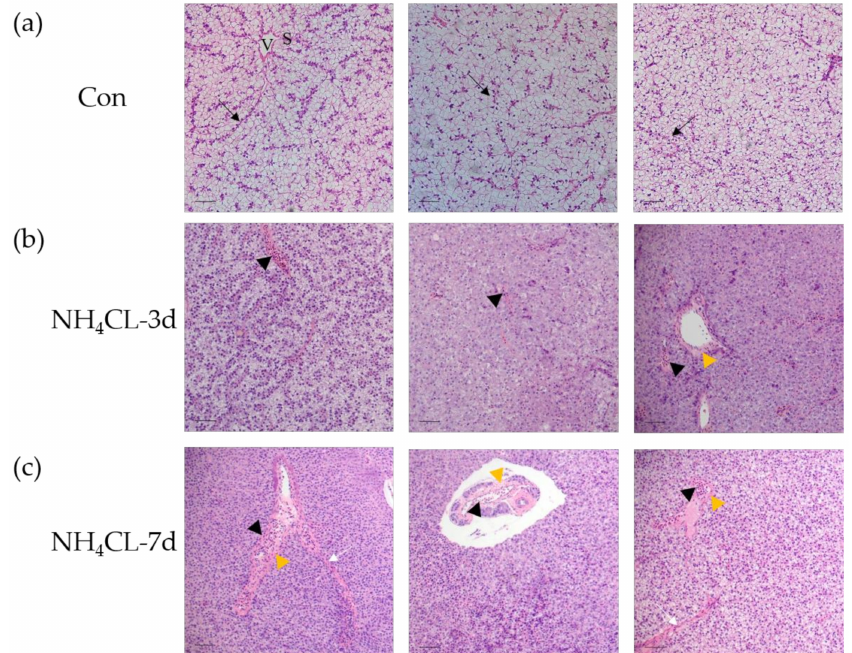
Figure 1. Ammonia exposure affected largemouth bass liver health. Hematoxylin-eosin (H. & e.) staining of paraffin sections of perch liver after ammonia exposure. V: venous tube; S: hepatic sinuses; black arrow: hepatic cord structure; black triangles: infiltration of inflammatory cells; yellow triangle: thickened vascular epithelium; white arrow: hepatic sinus congestion; scale, 50 µ m. ( a ) control group; ( b ) ammonia exposure for 3d; ( c ) ammonia exposure for 7